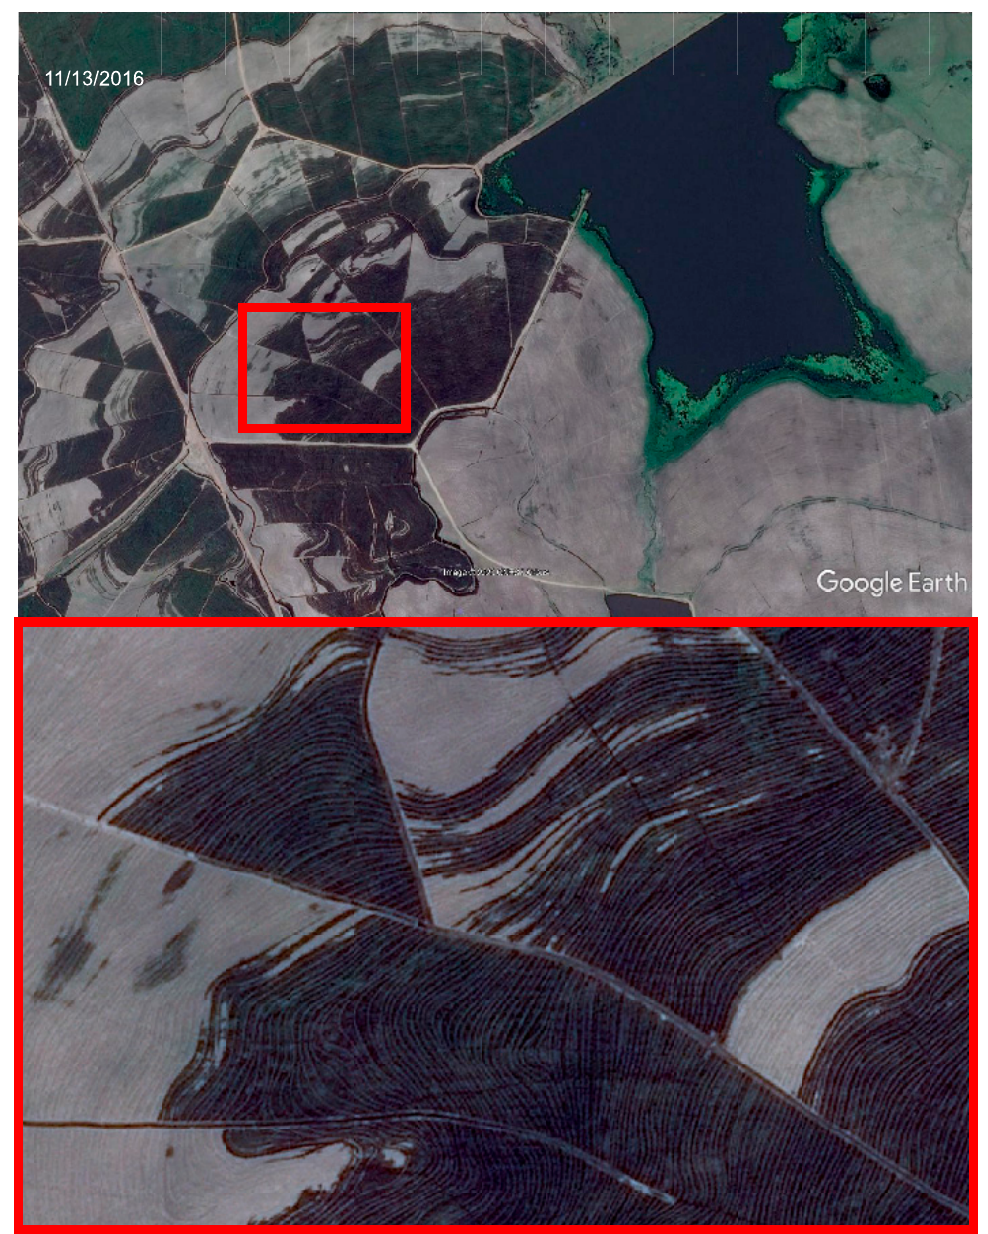
Figure 9. Google Earth image demonstrating the flooding of rice fields in the Uruguaina region, southern Brazil.